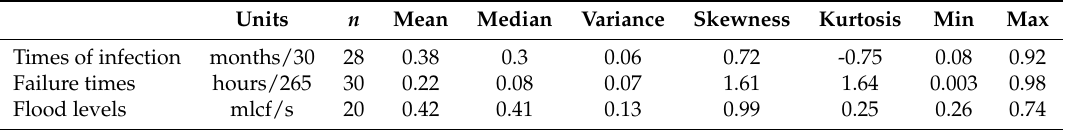
Table 1. Descriptive analysis for the times of infection, failure times and flood levels data sets.